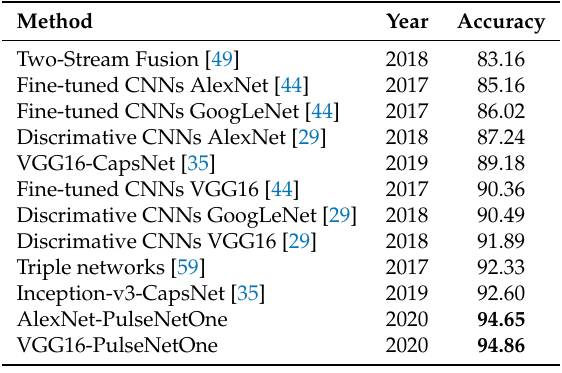
Figure 6. Barcharts for AlexNet and VGG16, illustrating the difference between the theoretical, CPU and GPU efficiency with respect to their computational speed and energy consumed on the NWPU-RESISC45 dataset. Table 7. A comparison between state-of-the-art and PulseNetOne results on the NWPU-RESISC45 dataset. The entries in bold show the method with the best classification for the